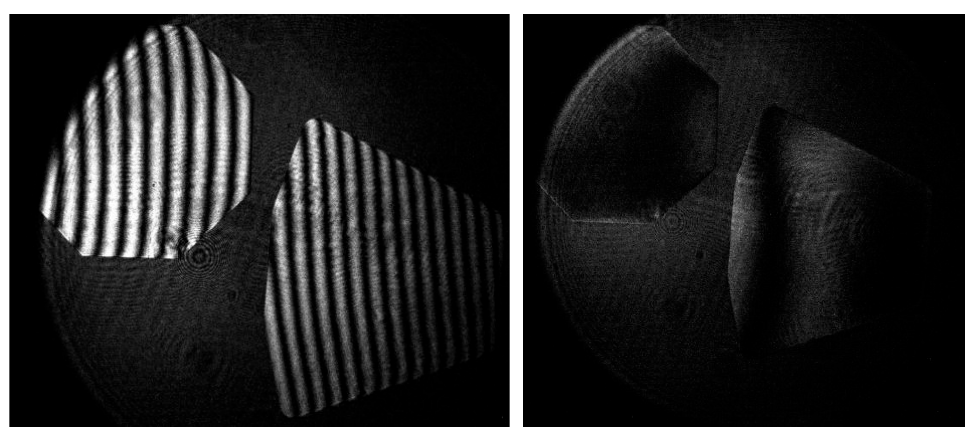
Figure 8. Interference fringe of the original case ( left ), and nearly similar tip/tilt ( right ).